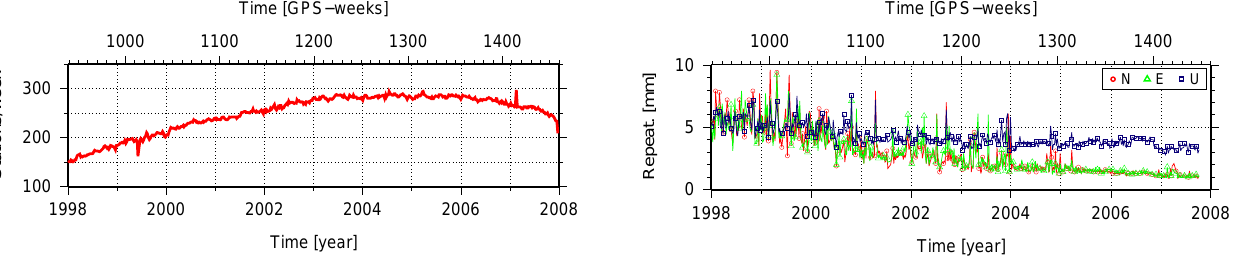
Fig. 2. Number of stations included in weekly GT1 solutions. tions.